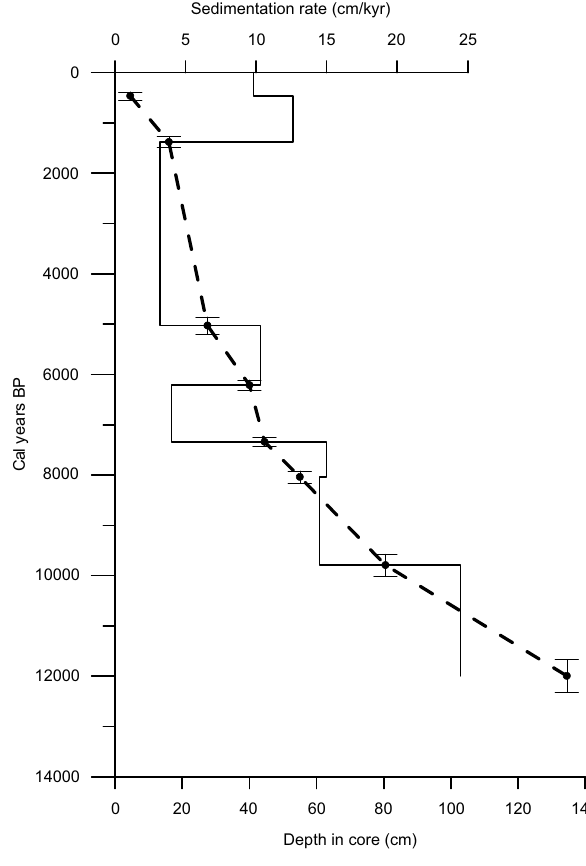
Fig. 2. Age model and sedimentation rate of JM09-KA11-GC. The 2 σ ranges are indicated on the dated levels. Chronology is estab- lished by linear interpolation between calibrated ages.